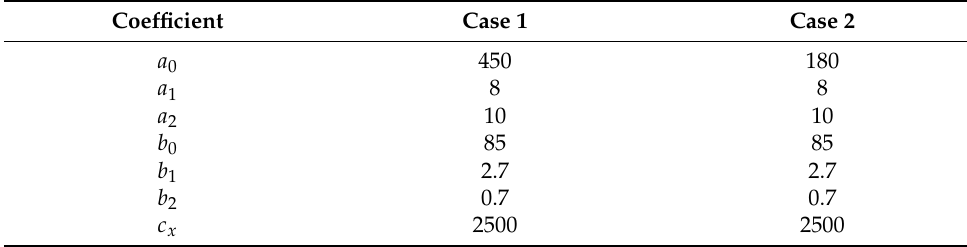
Table 2. Coefficients for the modified Dörr and Kloker model.